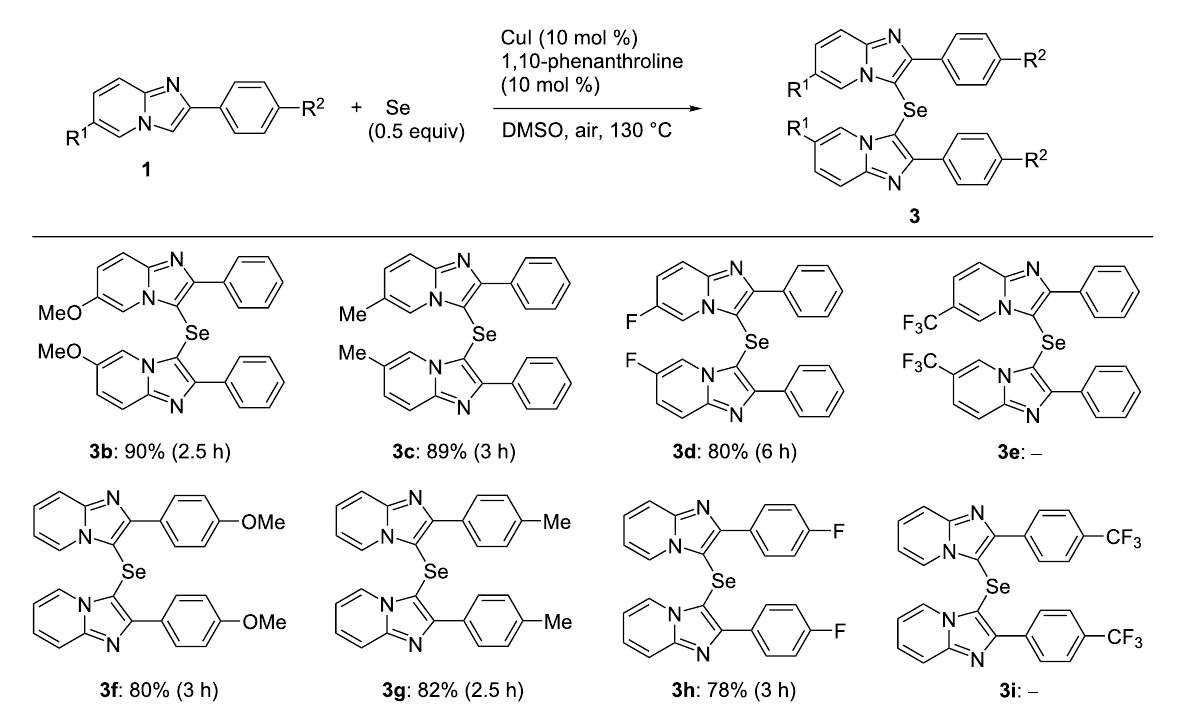
Figure 4: The synthesis of bis(2-arylimidazopyridin-3-yl) selenides. Reaction conditions: 1 (2 mmol), Se (1 mmol), CuI (0.2 mmol), 1,10-phenanthro- line (0.2 mmol), DMSO (8 mL), 130 °C. The isolated yield is given.